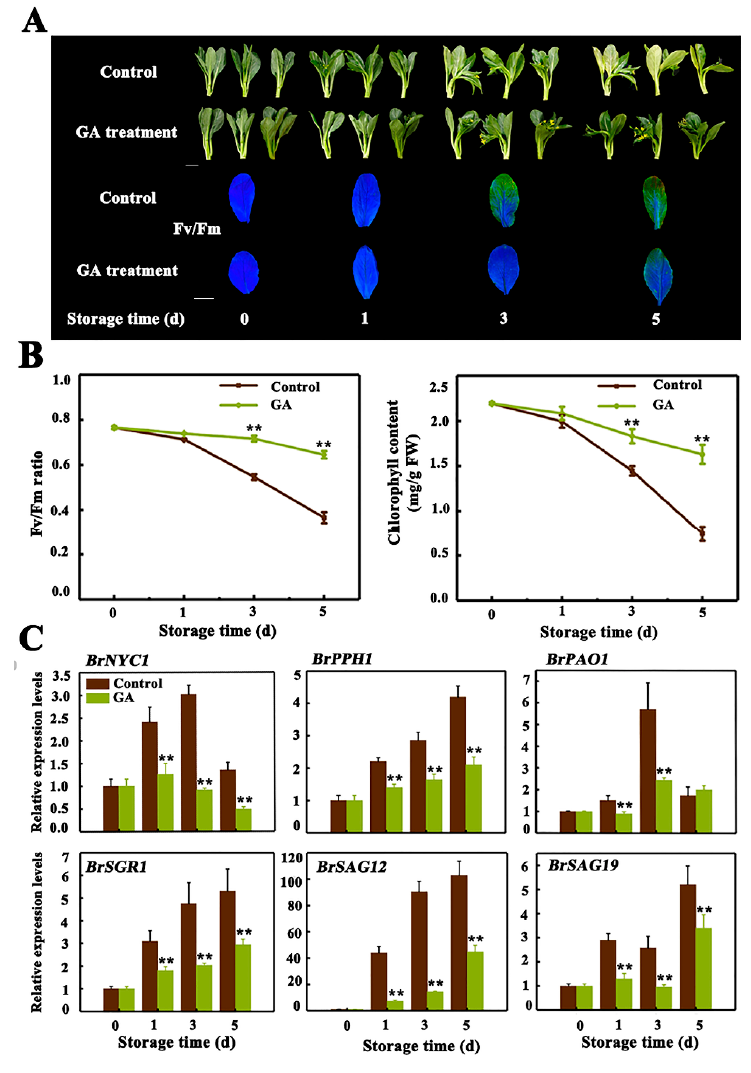
Figure 1. Gibberellin A3 (GA 3 ) treatment delays leaf senescence of Chinese flowering cabbage. ( A ) Appearance and chlorophyll fluorescence imaging (Fv/Fm) of control and GA 3 -treated cabbage leaves during senescence. Bar = 5 cm . ( B ) Change of Fv/Fm and total chlorophyll content in control and GA 3 -treated cabbage leaves during senescence. ( C ) Relative expression of four CCGs ( BrNYC1 , BrPPH1 , BrPAO1 and BrSGR1 ) and two senescence-associated genes ( BrSAG12 and BrSAG19 ), in control and GA 3 -treated cabbage leaves during senescence. Data presented in ( B ) and ( C ) are the mean ± S.E. of three biological replicates. Asterisks indicate a significant difference in GA 3 -treated leaves compared with control leaves (Student’s t -test: * p < 0.05 and ** p < 0.01).